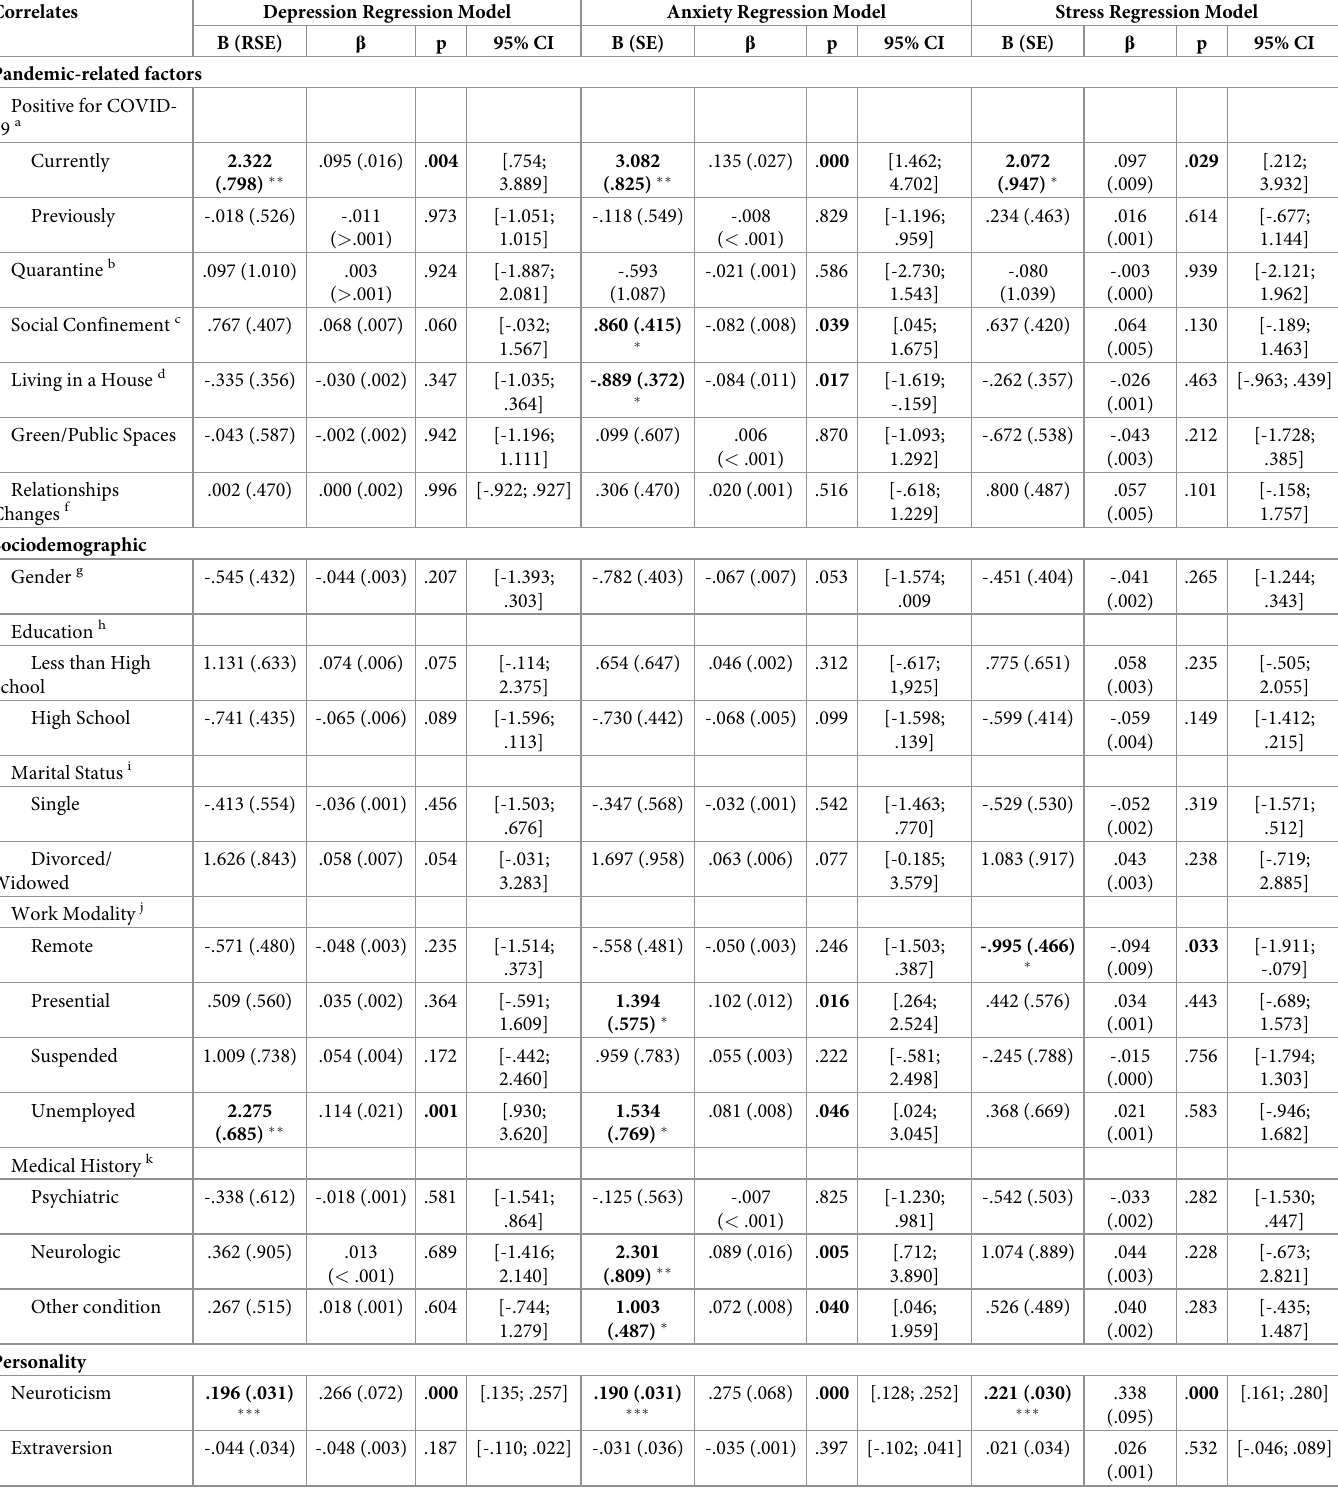
Table 3. Pandemic-related factors, sociodemographic, personality, and emotion regulation correlates of depression, anxiety, and